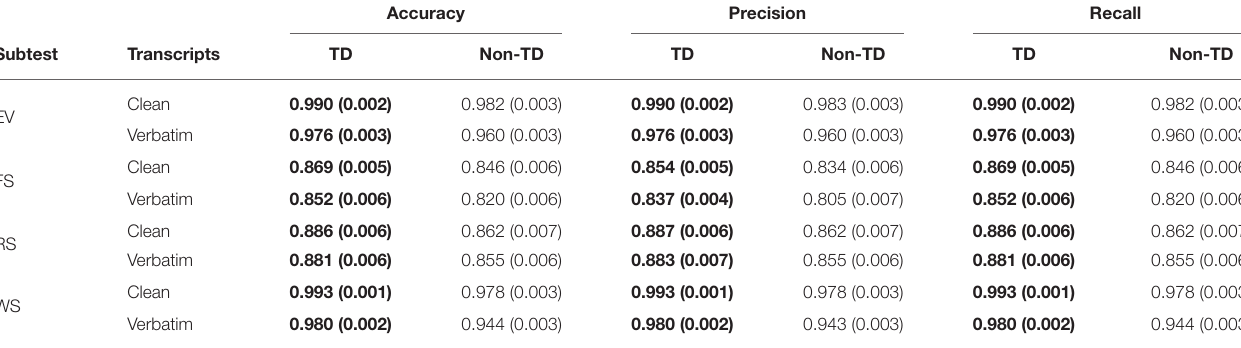
TABLE 3 | Distinguishing item-level scoring between typically developing (TD) and non-typically developing